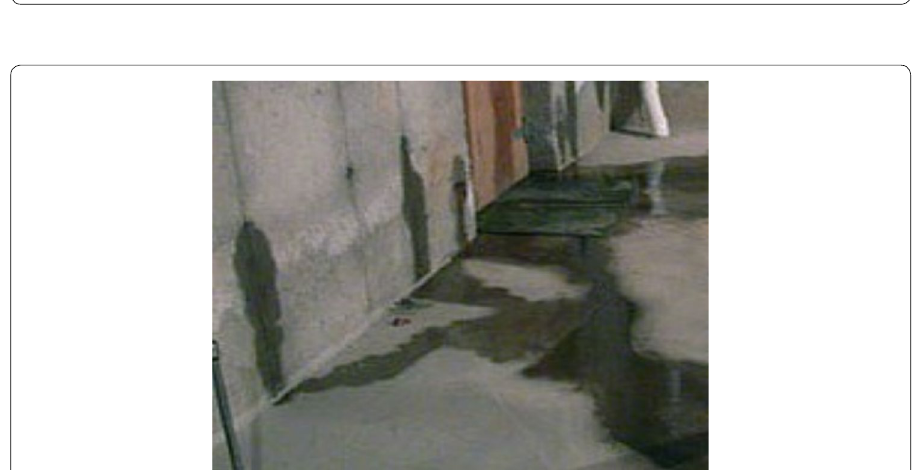
Fig. 4 Picture of seepage through cracks on